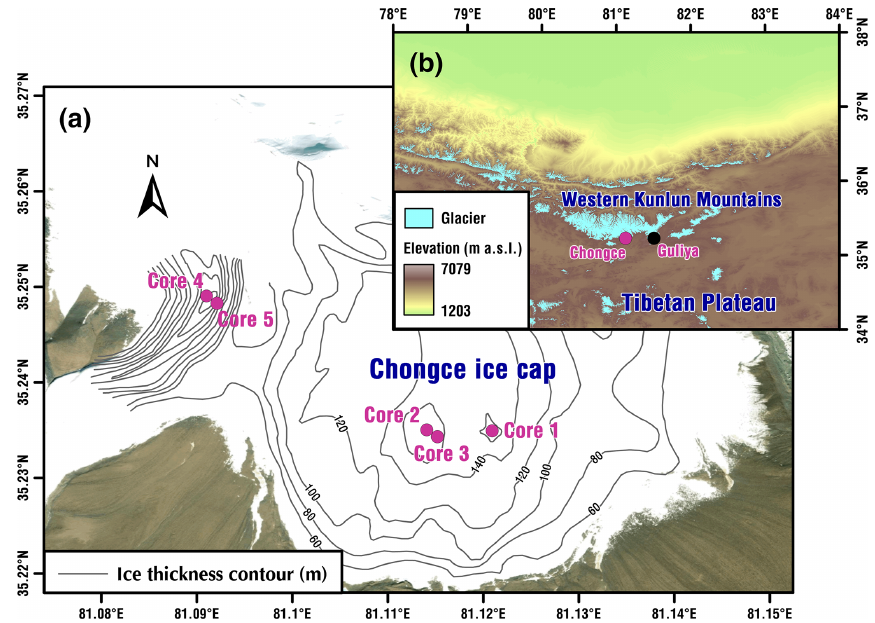
Figure 1. (a) Satellite image of the Chongce ice cap with location of the ice core drilling sites (deep rose dots). Ice thickness contours were superimposed on the image of the glacier. (b) Topographic map of the northwestern TP. The satellite imagery map is available at https://www.mapsofworld.com/satellite-map/world.html (last access: 13 July 2018). The topographic data were extracted using the Shuttle Radar Topography Mission (SRTM) 90m DEM digital elevation database, available at http://srtm.csi.cgiar.org/ (last access: 13 July 2018). Data of glaciers are from the Global Land Ice Measurements from Space (GLIMS; available at http://www.glims.org, last access: 13 July 2018, GLIMS and NSIDC,